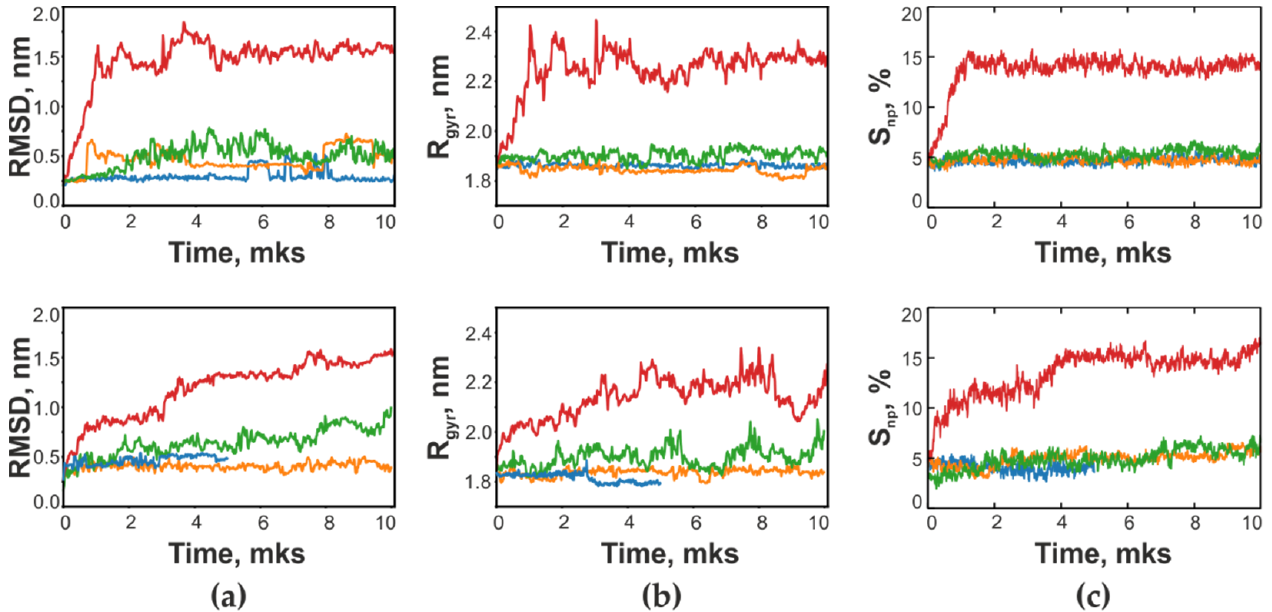
Figure 3. Evolution of the RTA (on top) and MLA (on bottom) properties in the course of MD simulations in different environments. The following characteristics of the toxin molecules are presented: RMSD from the initial structure ( a ); radius of gyration ( b ); hydrophobic accessible surface area ( c ). Blue, orange, green, and red curves correspond to MD simulations of the A subunits in water at 310 and 340 K, in urea/water, and in chloroform/methanol mixtures, respectively. MD data for MLA were taken from [17].